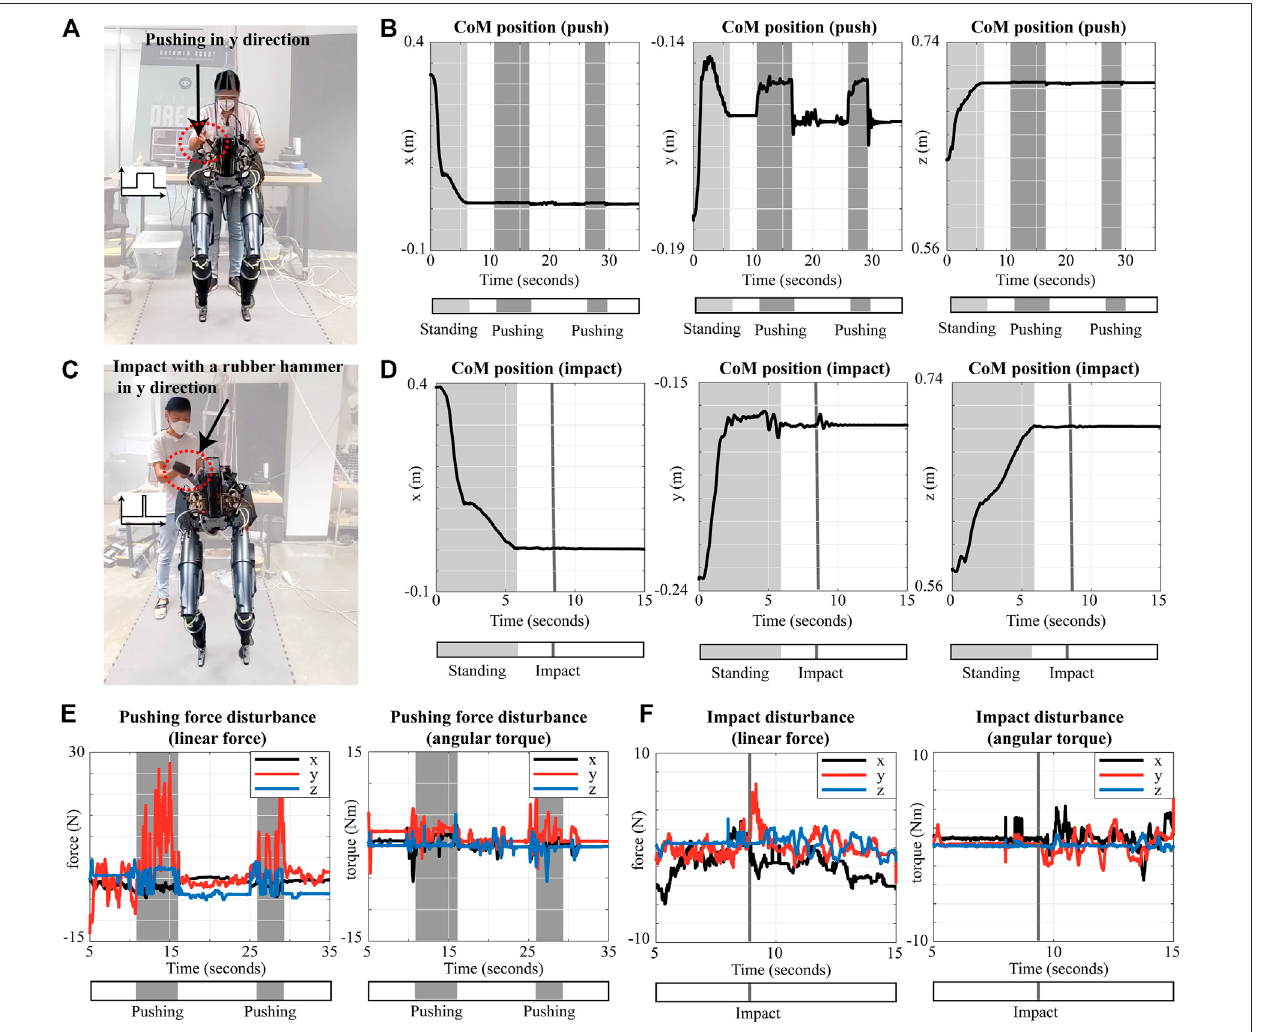
FIGURE 9 | Experiment results with the same scenarios with the simulations in 4.1.1 and 4.1.3 : pushing (A , B) and impacting (C , D) the pelvis of Draco2 in double support phase. The estimated external disturbance ^ F t is computed when pushing (E) and impacting (F) the robot.